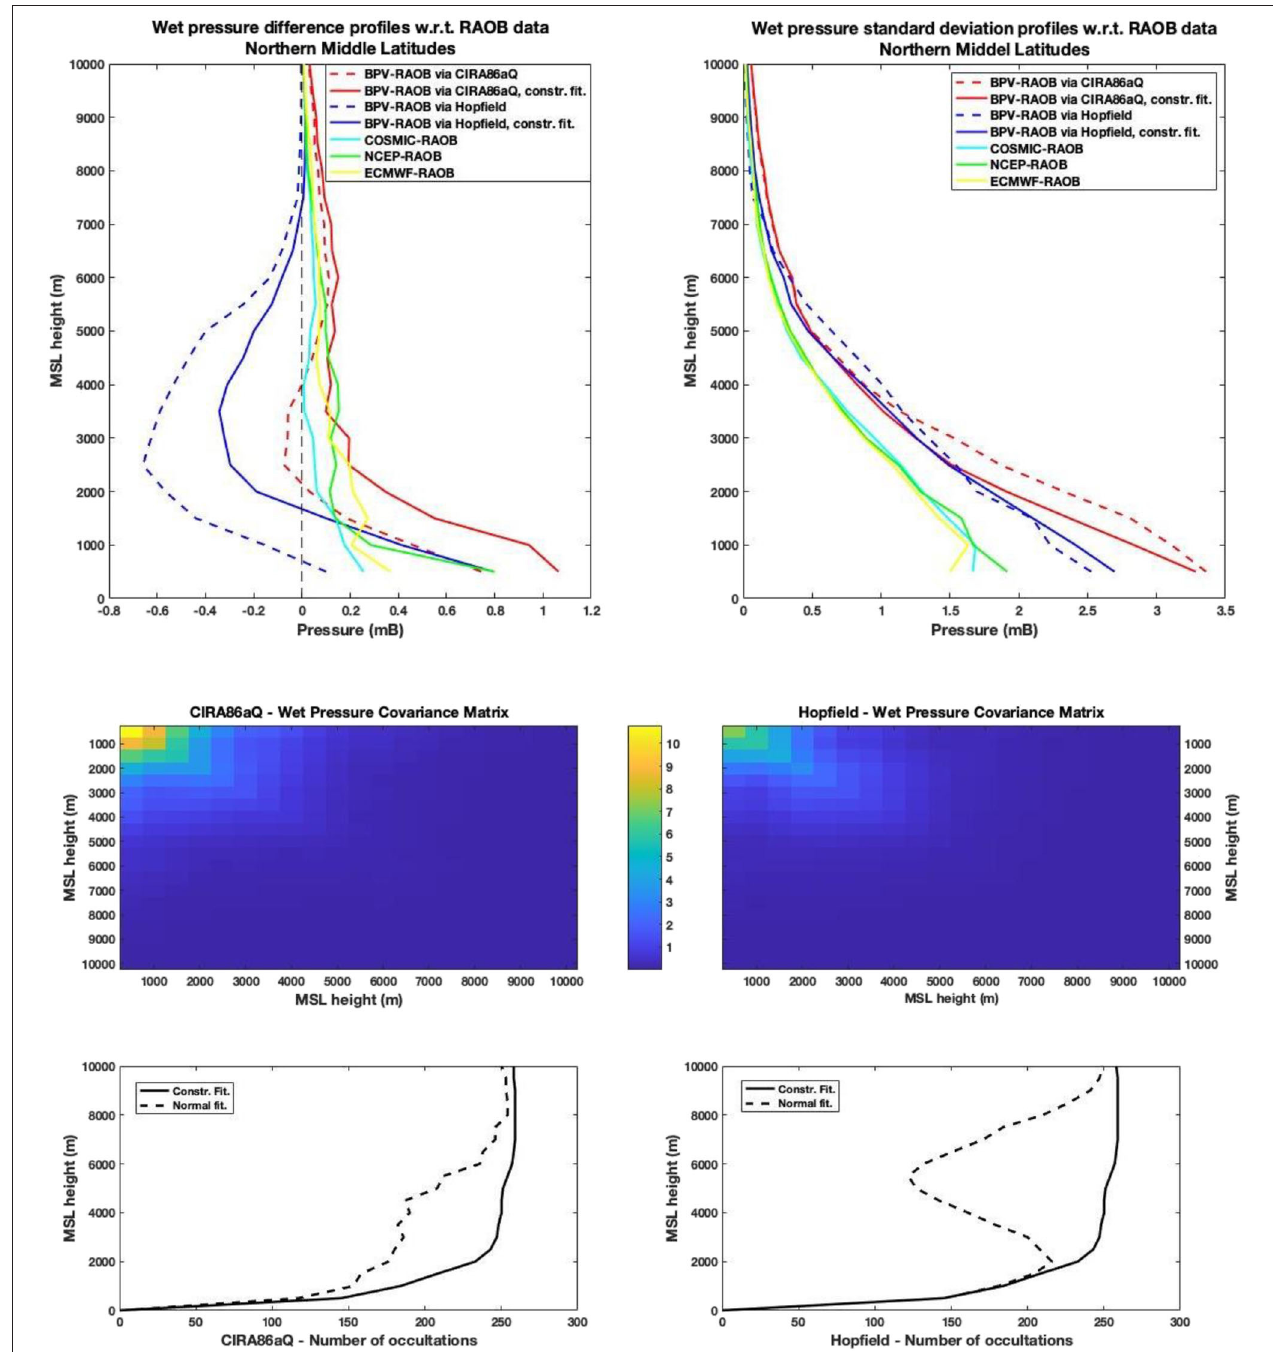
FIGURE 8 | Top: Difference (left) and standard deviation (right) profiles for the wet pressure at Northern Middle Latitudes, with respect to the RAOB values. Middle: Covariance error matrices for the constrained CIRA86aQ case (left) and the constrained Hopfield case (right). Bottom: Number of RO observations considered, in both the constrained and unconstrained case, for the CIRA86aQ (left), and the Hopfield (right).